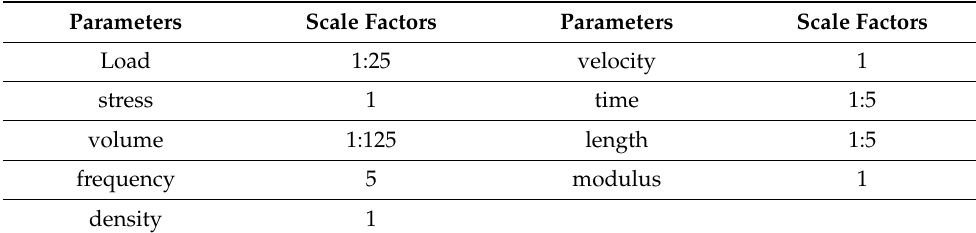
Table 1. Experimental model scale